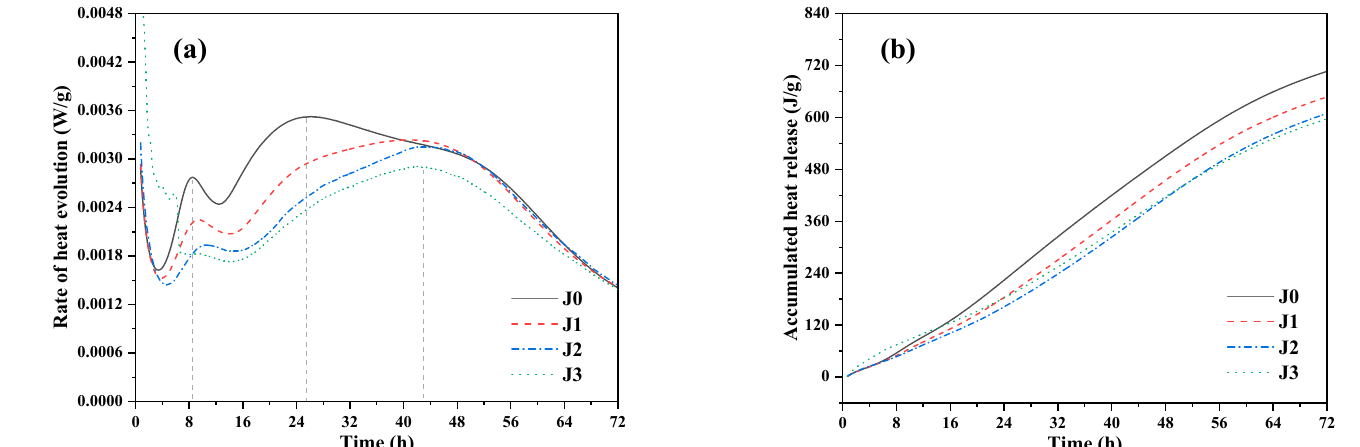
Figure 9. Effect of SRA on the surface tension of water and simulated pore solution.